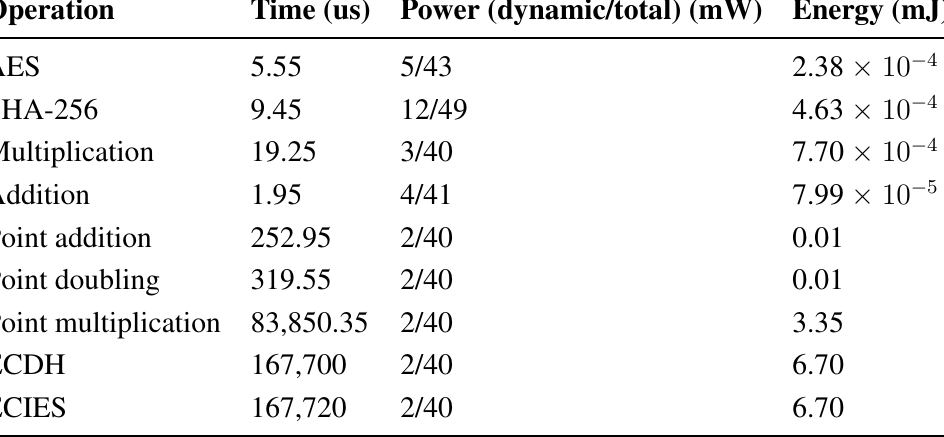
Table 8. Performance summary of the B-163 accelerator at 10